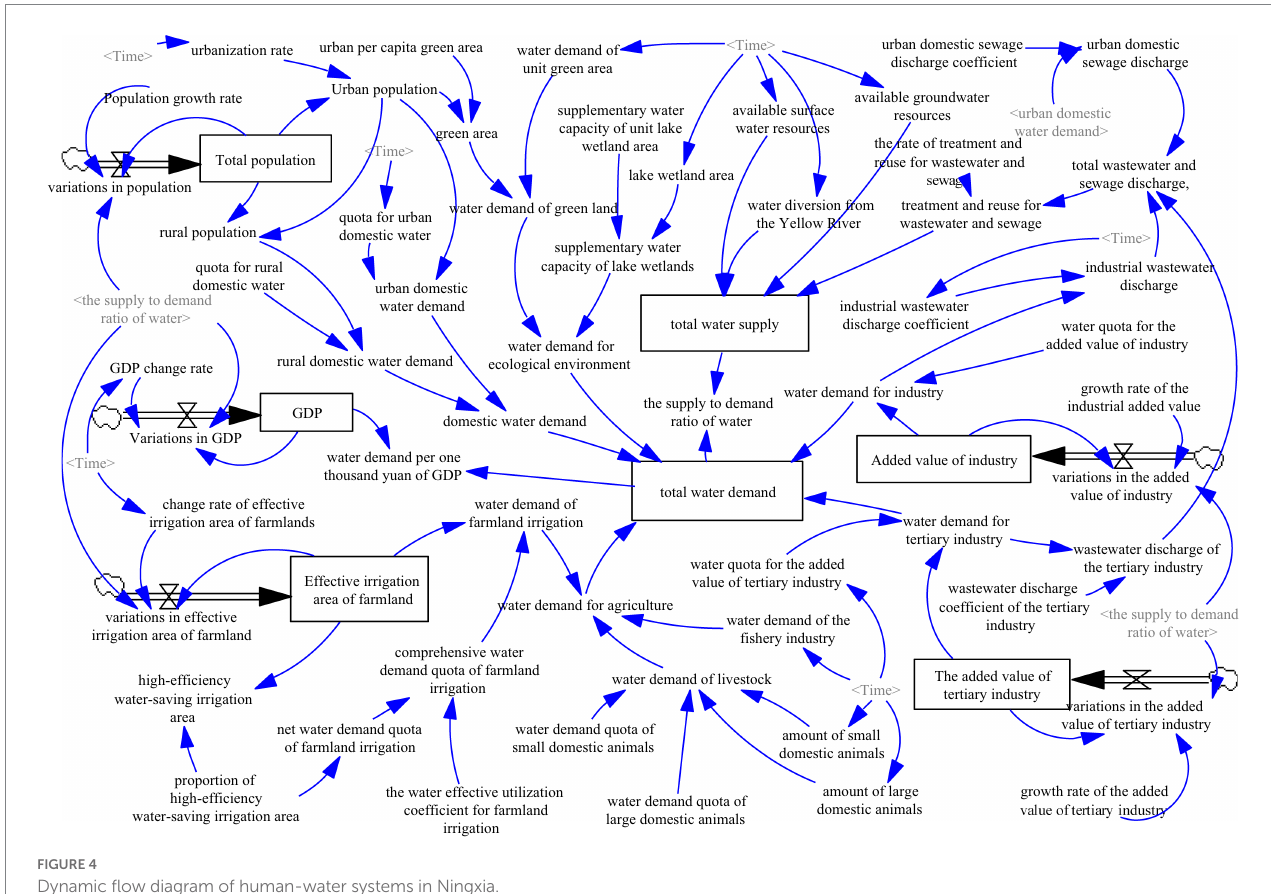
FIGURE 4 Dynamic flow diagram of human-water systems in